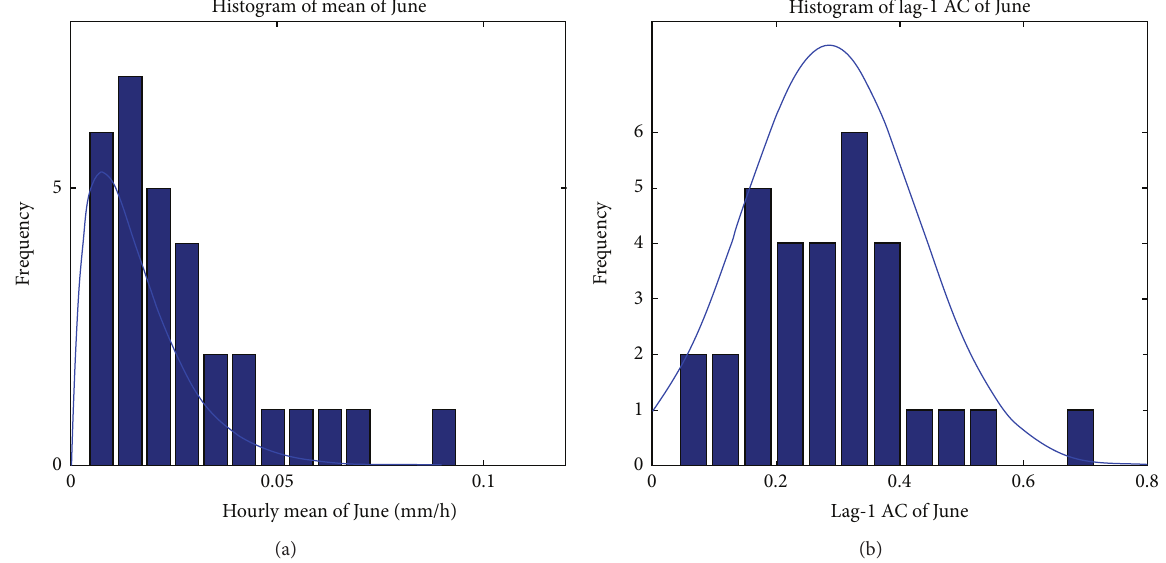
Figure 6: Histograms and the fitted gamma and normal distribution of hourly mean (a) and lag-1 autocorrelation coefficients (b) at the gauge TX-4300 for the month of June. From these distributions, MEAN1 and AC1 are randomly drawn.